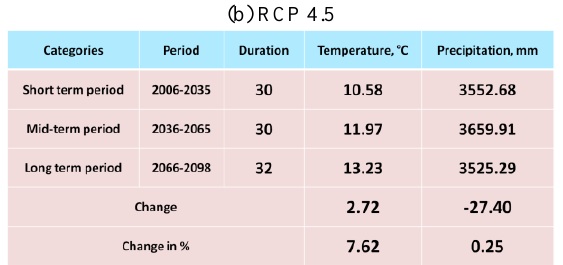
Figure 14. Spatial change in baseflow under each scenario